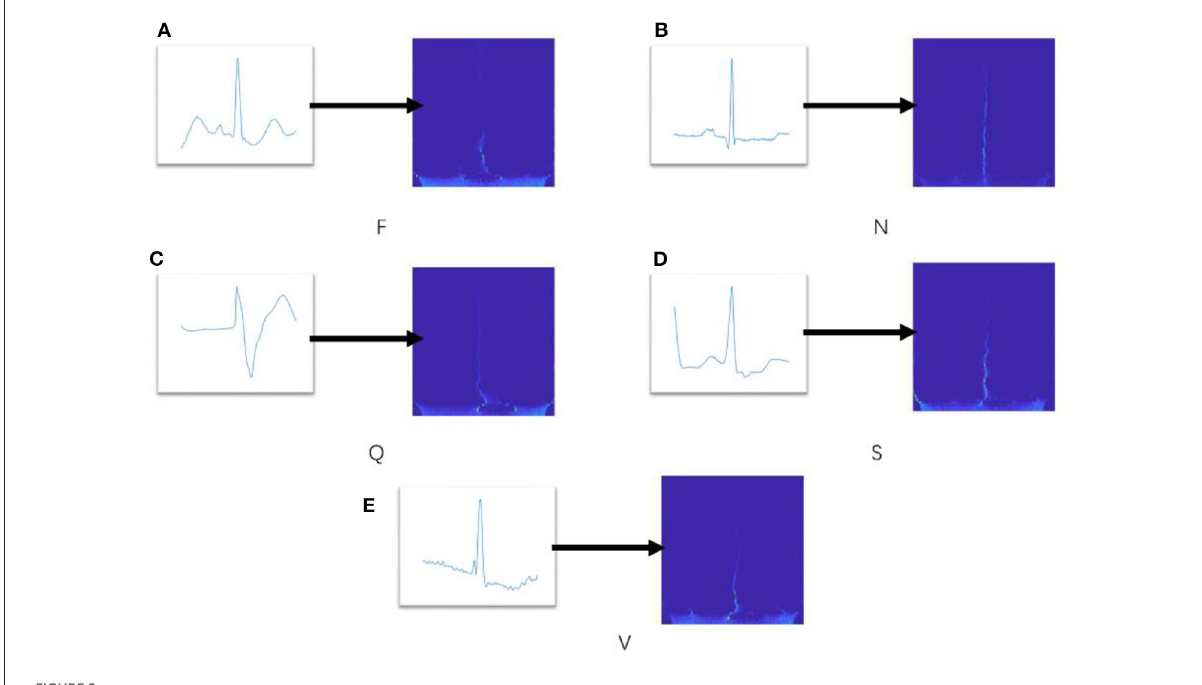
FIGURE2 (A–E) Spectrograms of several ECG signals via TSST decomposition.